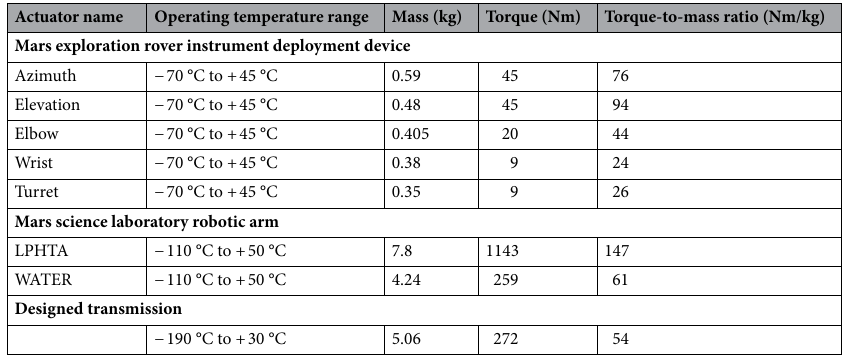
Table 1. A comparison of the torque-to-mass ratio of the designed transmission with the existing designs.